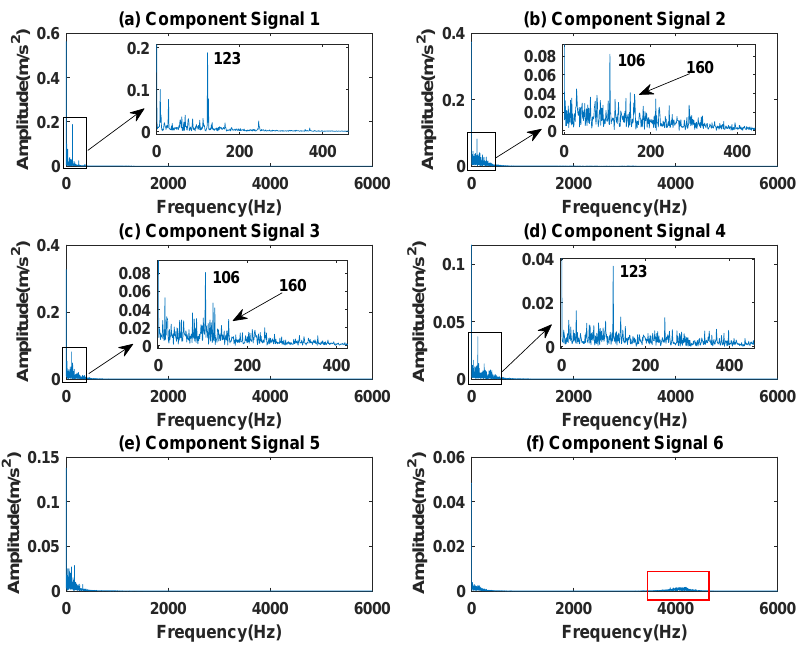
Figure 25. Decomposition results of FESVDP with m = 16 and J = 3: ( a – f ) envelop of 1st to 6th subcomponents,